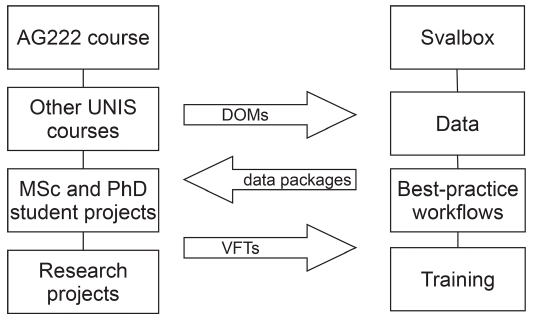
Figure 10. Schematic diagram of the synergies between the AG222 course (and other UNIS courses and research activities) and the Svalbox